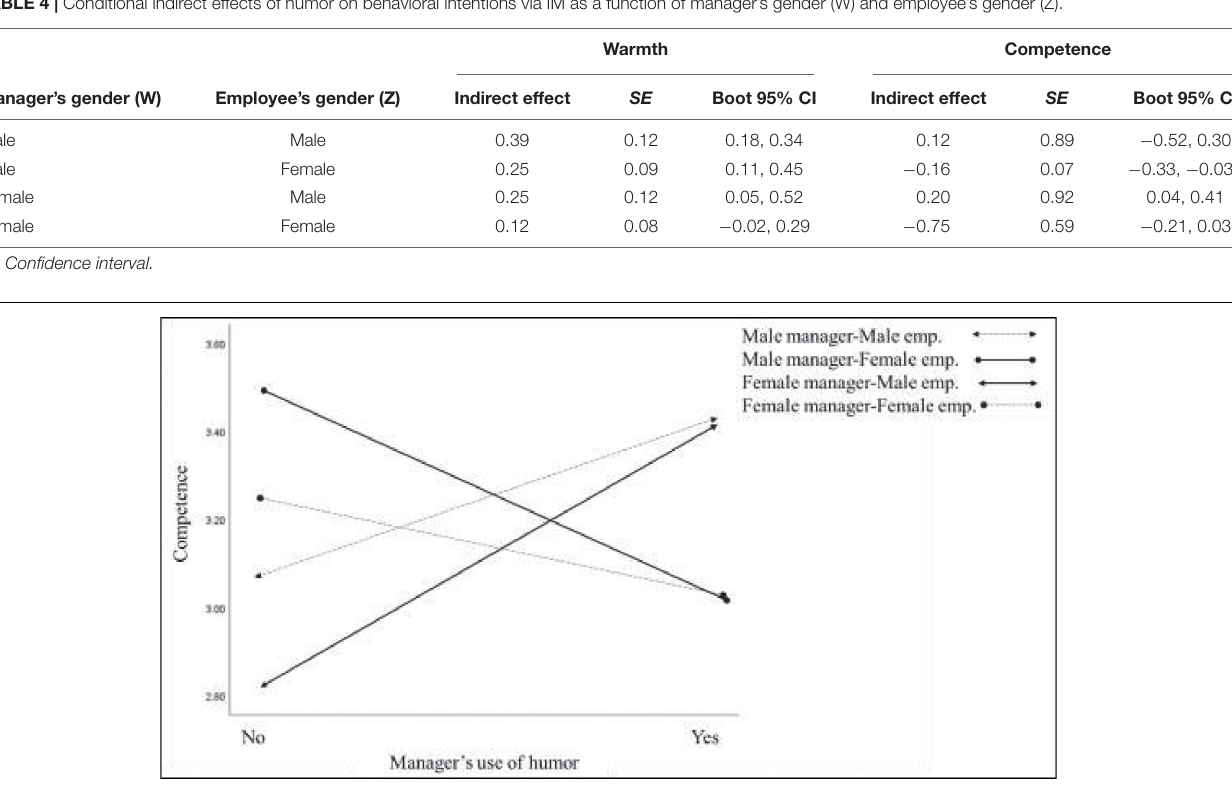
Frontiers in Psychology |